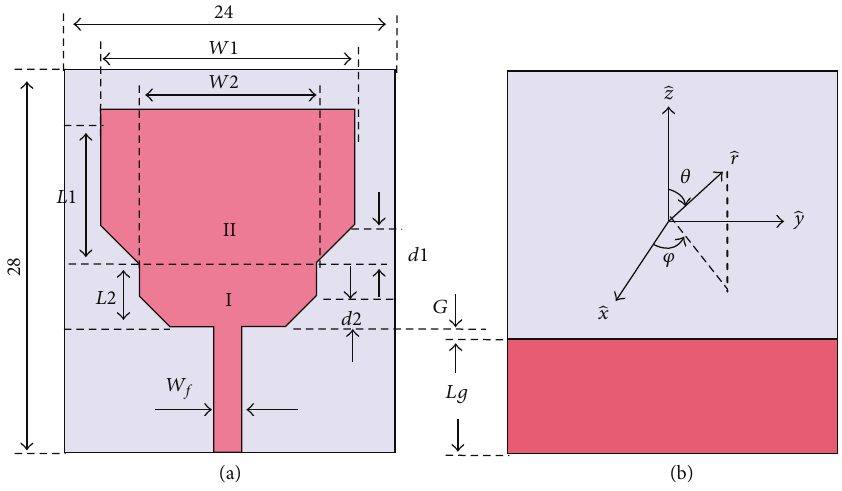
Figure 1: Geometry of the two-step beveled antenna: (a) top view and (b) bottom view.